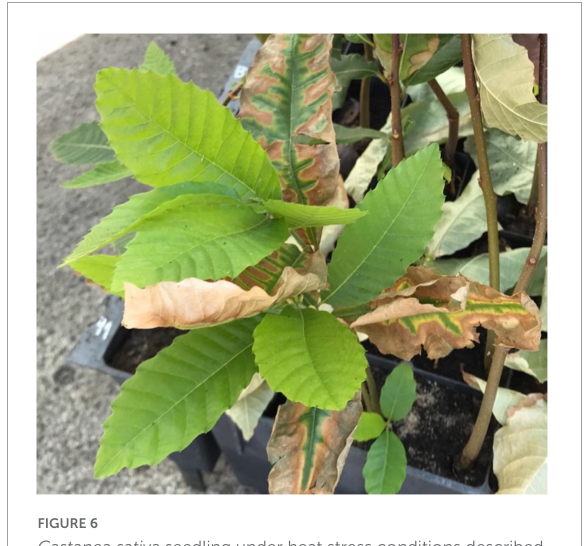
FIGURE6 Castanea sativa seedling under heat stress conditions described in Dorado et al.